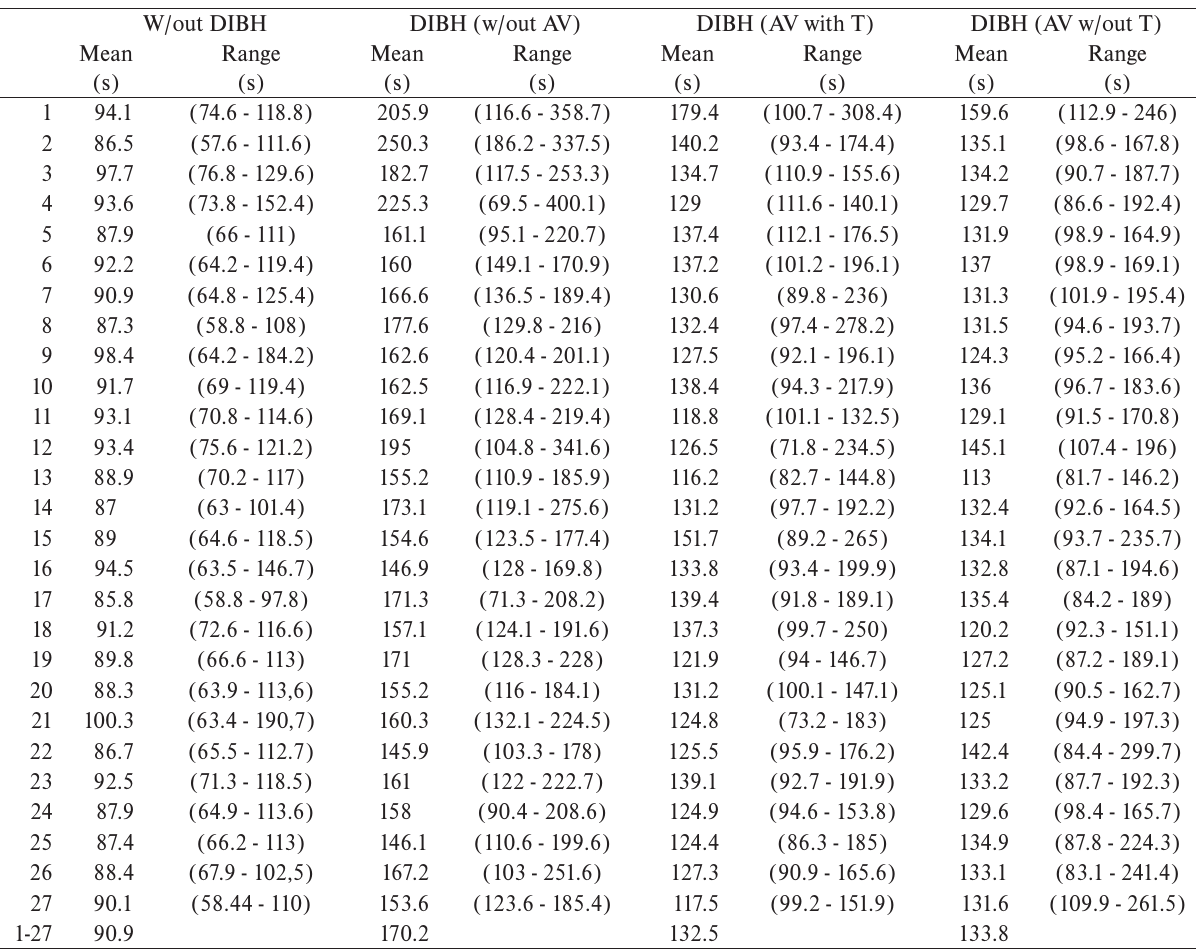
Table 2. Treatment times for each fraction related to 100